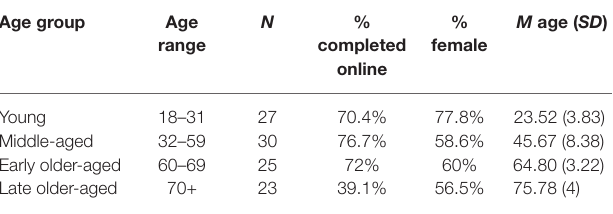
TABLE 1 | Study 1: Demographic information split by subjective age